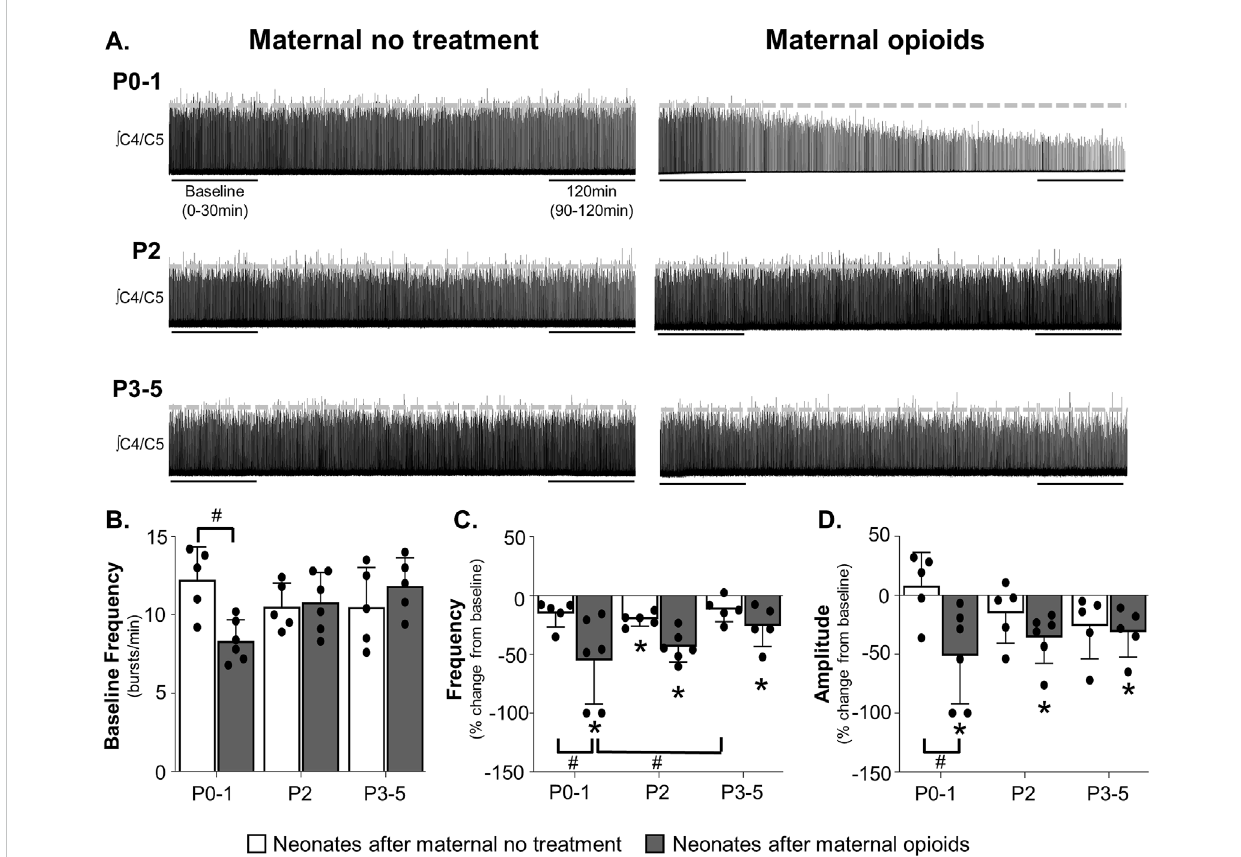
FIGURE 1 Maternal opioids age-dependently impair neural activity from isolated neonatal respiratory control networks. Representative neurograms (A) from isolated respiratory control networks show respiratory activity in neonatal brainstem-spinal cords were maintained in neonates after maternal no treatment at all ages and decreased in P0-1 neonates after maternal opioids. Baseline respiratory burst frequencies [0 – 30 min, (B) ] were similar in neonates after maternal no treatment (white bars) at all ages, reduced in P0-1 neonates after maternal opioids (grey bars), and unchanged in older (P2andP3-5)neonatesaftermaternalopioids.Respiratoryburstfrequencies (C) decreasedfrombaselineinP2neonatesaftermaternalnotreatmentand inneonatesaftermaternalopioidsatallages.RespiratoryburstfrequencydecreasedinP0-1neonatesaftermaternalopioidscomparedtoP0-1andP3-5 neonates after maternal no treatment. Respiratory burst amplitudes (D) weremaintained in all neonatesafter maternal no treatment and decreased from baseline in all neonates after maternal opioids. Respiratory burst amplitudes decreased in P0-1 neonates after maternal opioids compared to P0-1 neonatesaftermaternalnotreatment(* p < 0.05differentfrombaseline; # p < 0.05differentfromneonatesaftermaternal notreatment;Two-andThree- way ANOVA; Bonferroni post-hoc